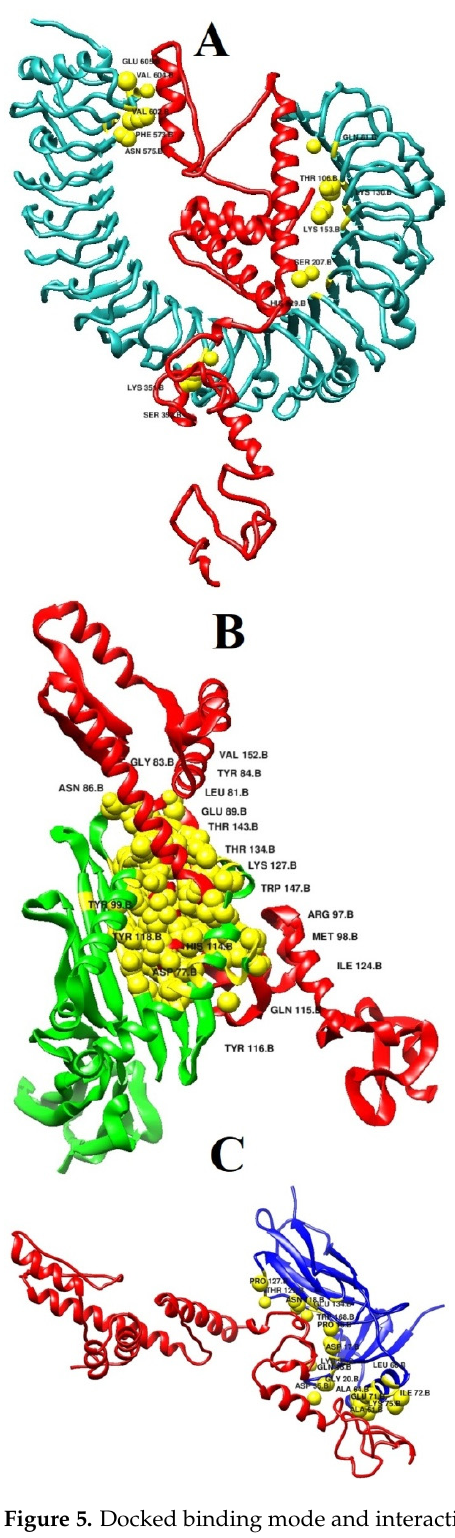
Figure 5. Docked binding mode and interactions of the vaccine with respect to immune receptors. ( A ) vaccine-TLR4, ( B ) vaccine-MHC-I, and ( C )